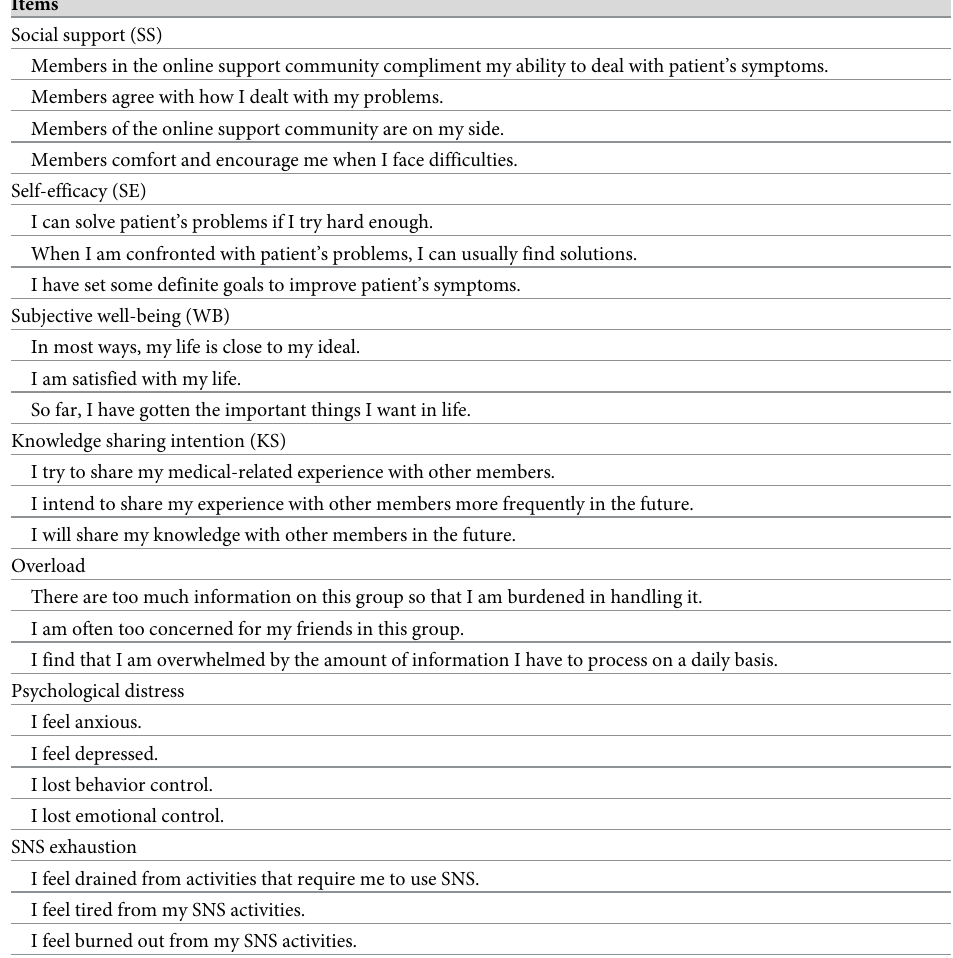
Table 1. Measurement items. Items Social support (SS) Members in the online support community compliment my ability to deal with patient’s symptoms. Members agree with how I dealt with my problems. Members of the online support community are on my side. Members comfort and encourage me when I face difficulties. Self-efficacy (SE)